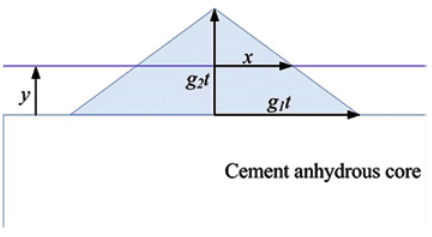
Figure 1 Schematic illustration of nuclei growth on a cement parti- cle (cone